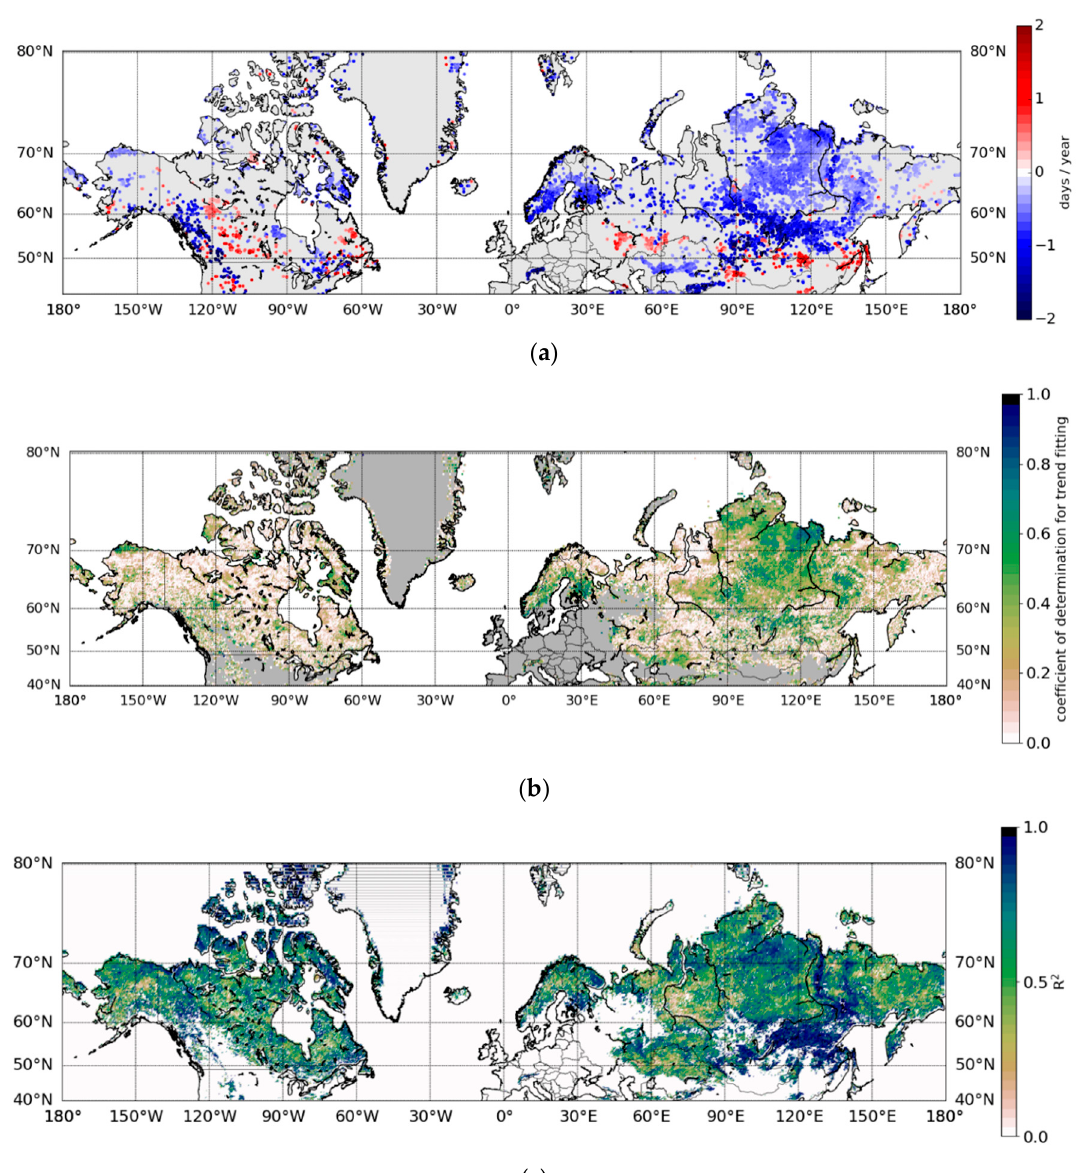
Figure 8. ( a ) The rates of change for the start day of melt between 1982 and 2015 using 5-year rolling mean albedo (showing cases for which R 2 of the fit was larger than 0.5). The negative rates of change mean earlier onset of melt and the positive rates of change mean later dates of onset of melt. ( b ) The coefficient of determination ( R 2 ) values for the trend fitting for start day of melt. ( c ) The multiple variable correlation ( R 2 ) between ERA-Interim climate data and start day of melt. R 2 value for linear correlation between the time that melt season started (day of year) and 3 climatic parameters for 14 days prior to the onset of melt. The climatic parameters used are the mean air temperature, accumulated precipitation and mean wind speed.